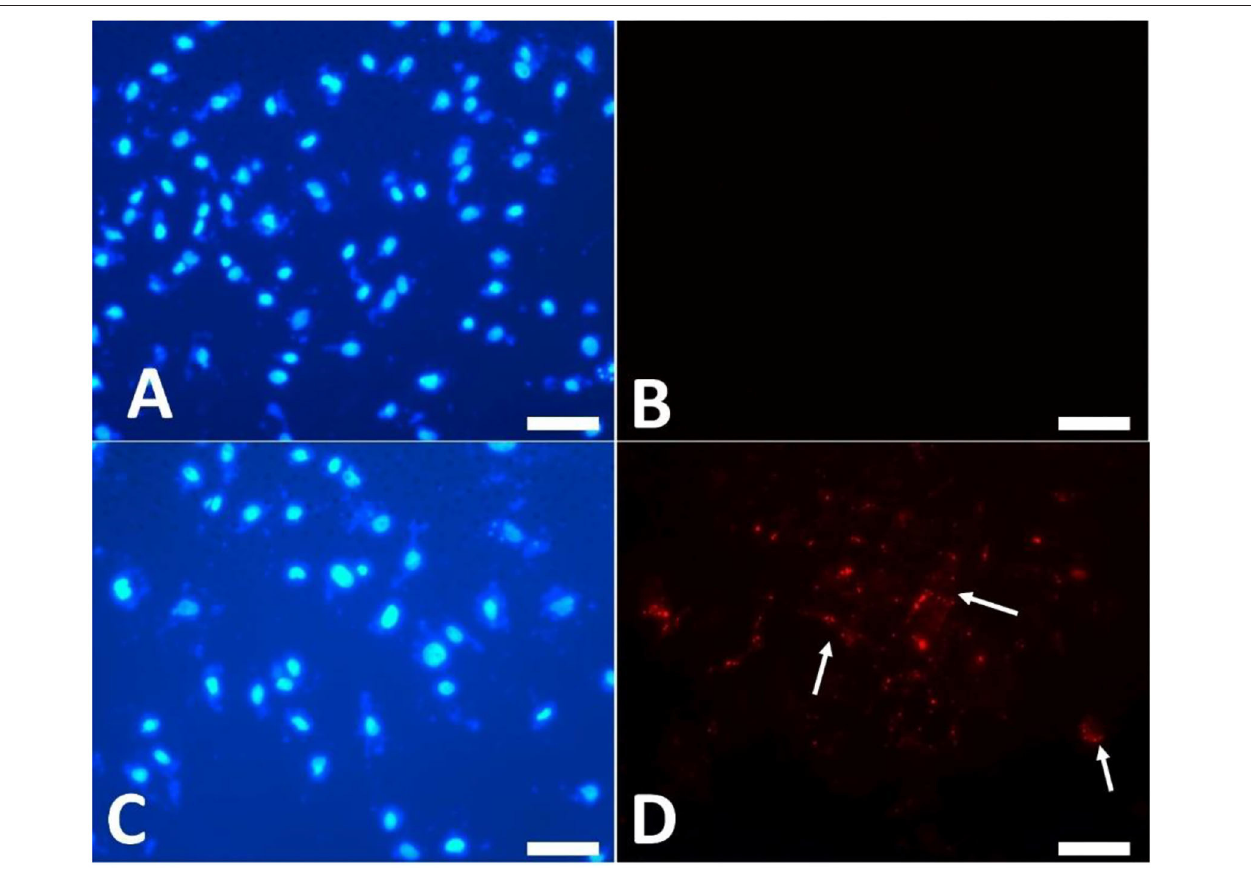
FIGURE 6 | Uptake of PKH26-labeled extracellular vesicles (EVs) by the cultured cumulus cells. (A,B) Control cells cultured in plain culture medium. (C,D) PKH26 dye was applied to the EVs and kept in the culture medium for 22h. (A,C) Nuclear staining by DAPI. (B,D) Localization of red fluorescence staining of EVs ( arrows ). Scar bar , 10 µ